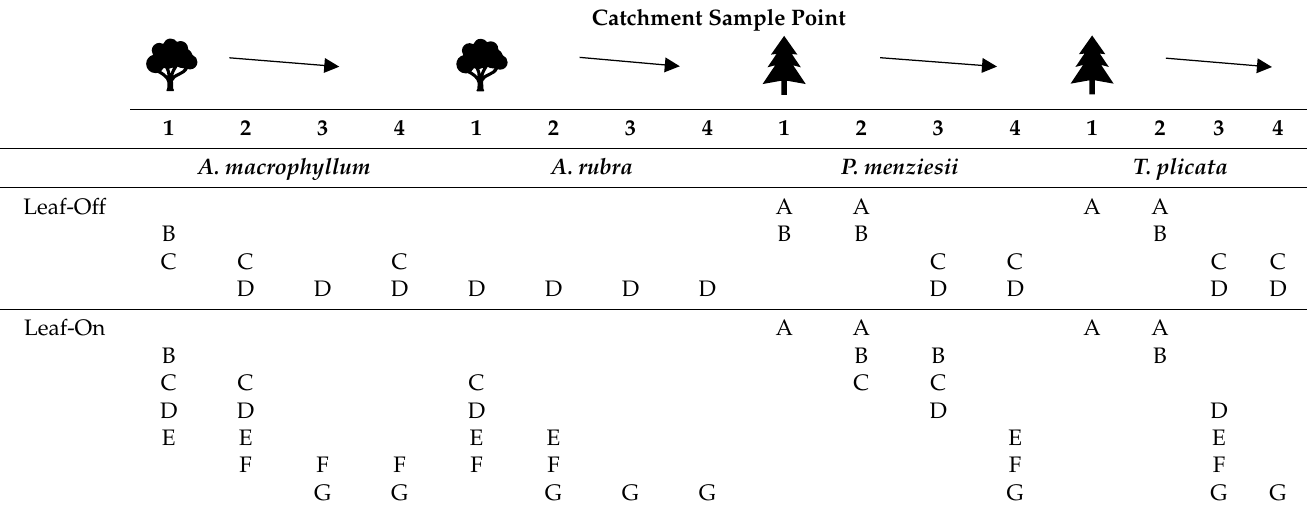
Table 2. Tukey’s test results from pairwise comparisons of species by sample point interactions. Shared letters within leaf-off and leaf-on periods represent non-significant differences ( p > 0.05), and non-shared letters represent significant pairwise differences among all species and sample points.